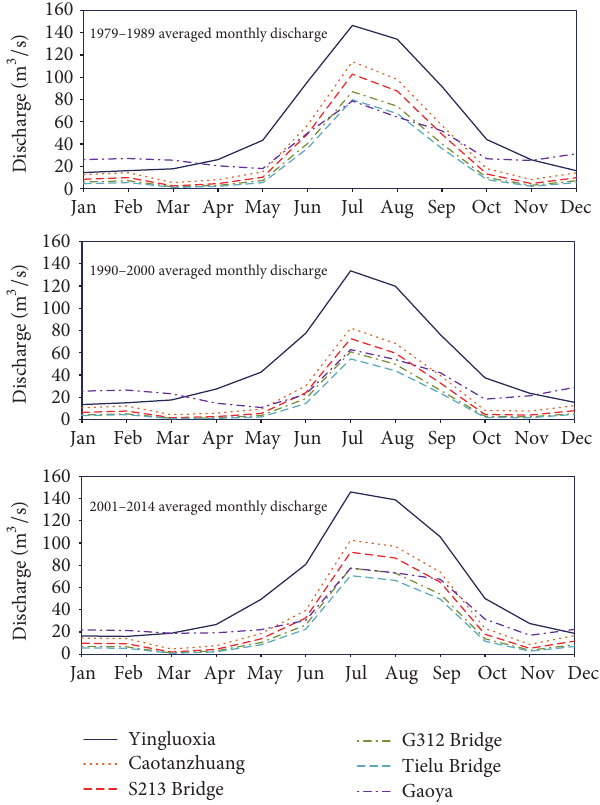
Figure 9: Multiyear averaged monthly discharge trends in three different